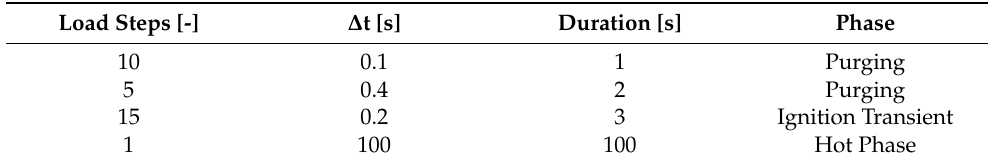
Table 9. Load and time steps considered in the numerical